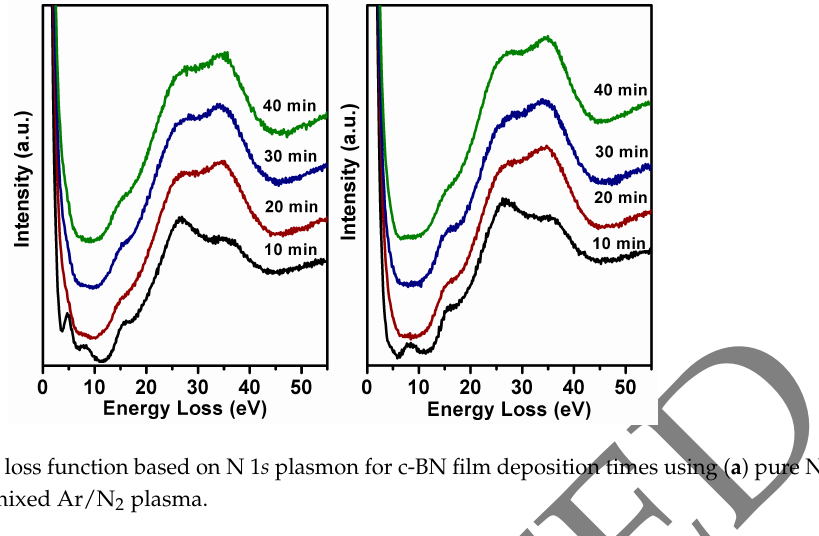
Figure 2. Energy loss function based on N 1 s plasmon for c-BN film deposition times using ( a ) pure N 2 plasma and ( b ) mixed Ar/N 2 plasma.